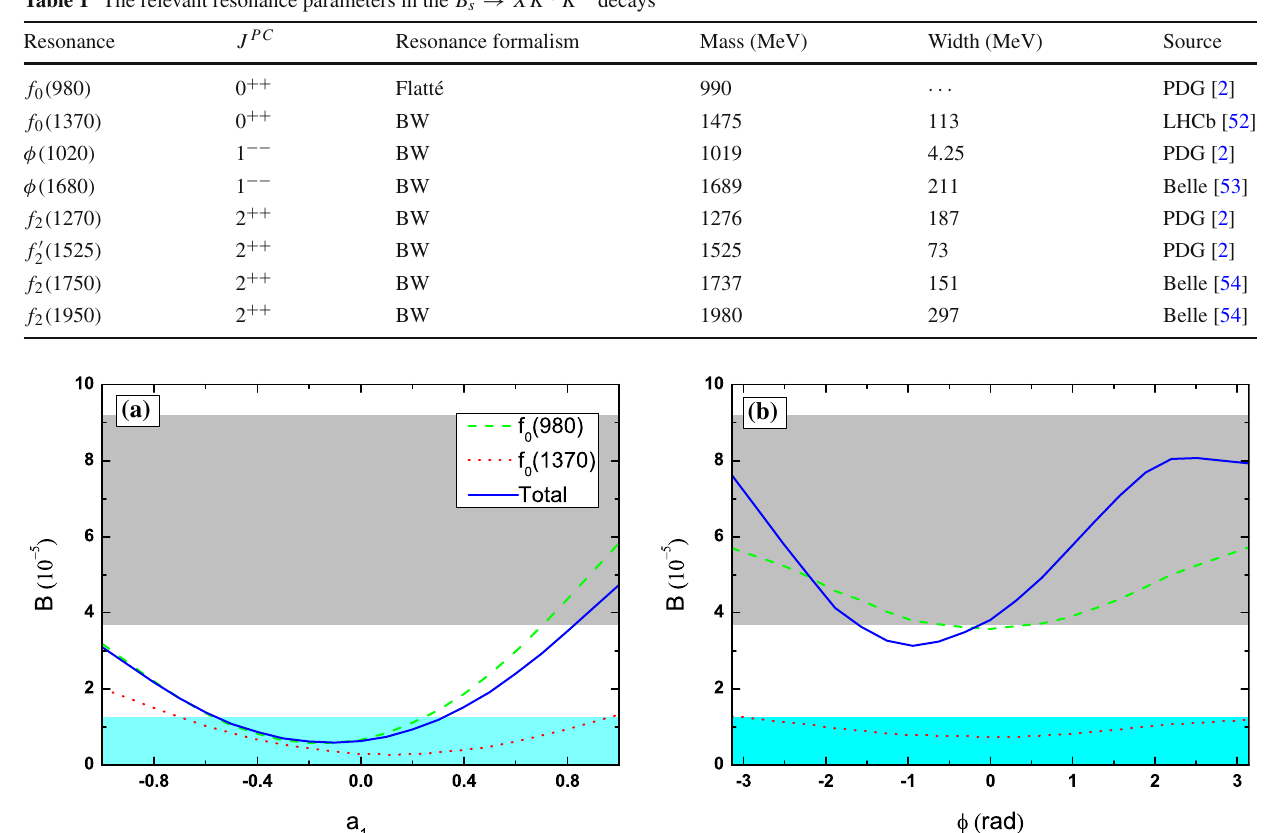
Fig. 2 The branching ratios (10 − 5 ) for the B s → J /ψ f 0 ( → K + K − ) decays as a function of a the Gegenbauer moment a 1 and b the phase φ of coefficient c f 0 ( 1370 ) with all other input fixed at the default values in Eq. (34). The dashed green, dotted red, and solid blue curves show